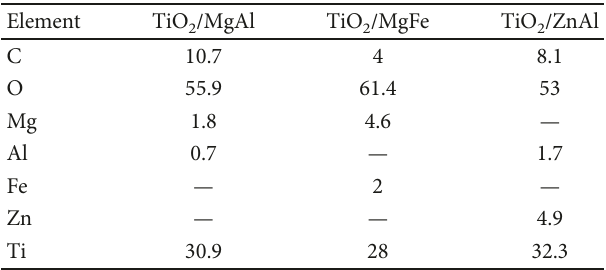
/MgAl, (b) TiO 2 Table 1: Analysis EDS for TiO